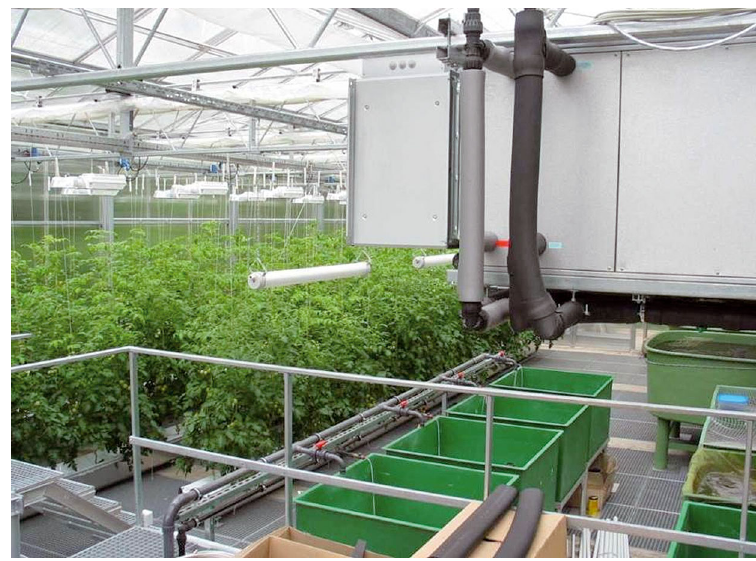
Fig. 2. ASTAF-PRO prototype during the test period in early April 2009, show- ing aquaculture fish tanks (green boxes) containing tilapia ( Oreochromis niloticus ) and hydroponic troughs with tomato plants Solanum lycopersicum and the air-conditioning system